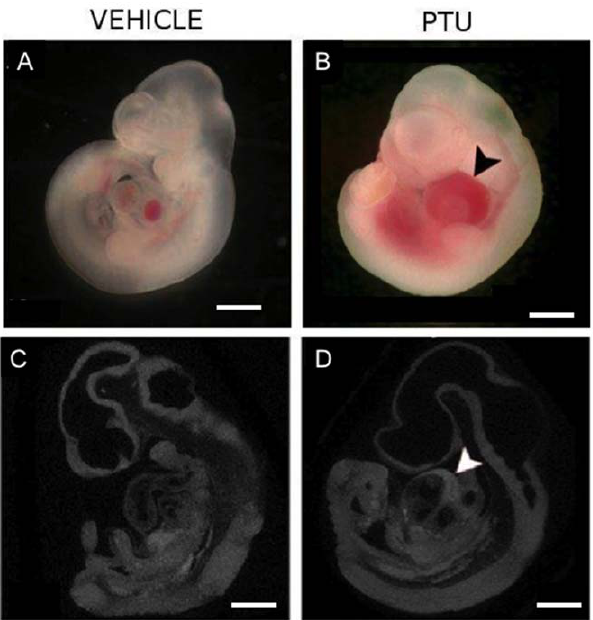
Figure 2. PTU exposure during embryogenesis induces blood in the pericardium. Representative images of E10.5 embryos treated with (A, C) vehicle and (B, D) PTU (100 mg/kg) showing blood in the pericardial sac of PTU-treated embryo (arrowhead). (C, D) MicroCT scans showing sagittal 3D images of whole embryos. Scale bars=0.5 mm.